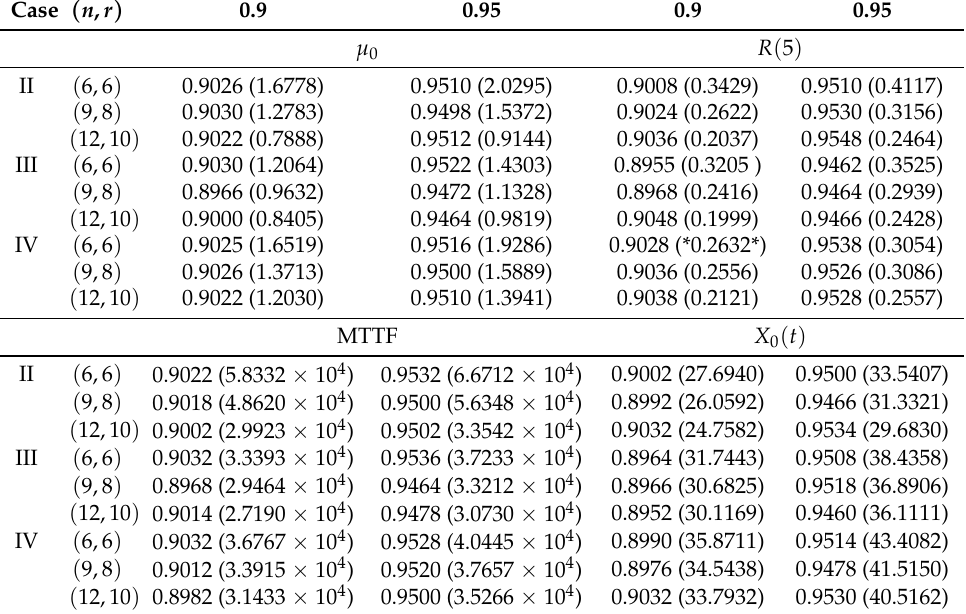
Table 3. The CPs and AILs (in parentheses) of quantities µ 0 , R ( 5 ) , MTTF and X 0 ( 8 ) for nominal levels 0.9, 0.95, based on 5000